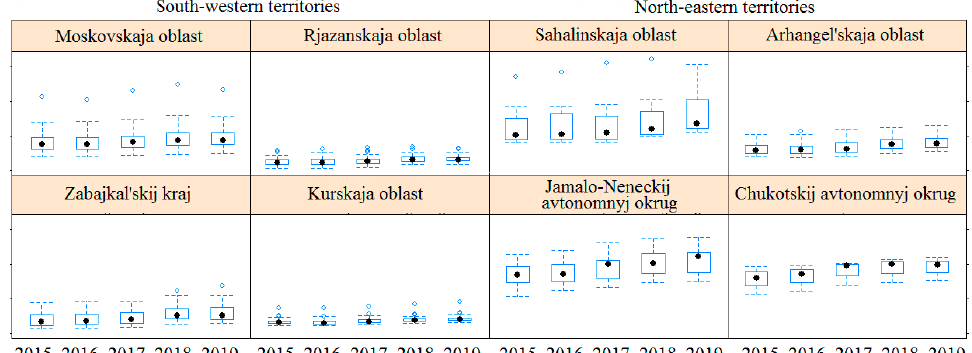
Figure 5. Box plots for average nominal employees’ wages of large, medium-sized and non-profit enterprises in certain regions of Russia in 2015–2019.